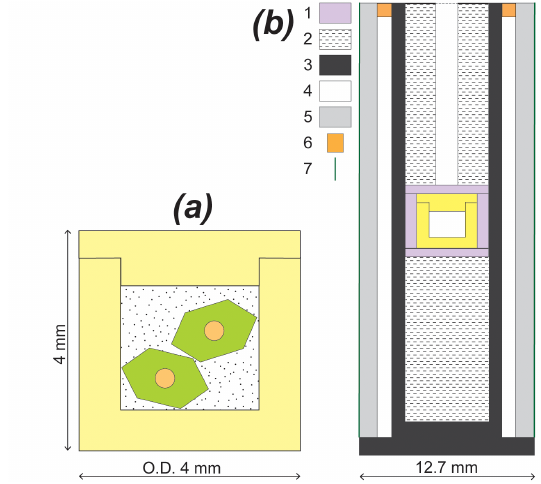
Figure 2. (a) Two olivine phenocrysts are loaded in a thick-walled Au 80 –Pd 20 container along with a mixture of NaCl and powdered olivine. The homogenization experiments are run at P – T conditions above the melting curve of sodium chloride, ensuring hydrostatic conditions inside the container. (b) Sketch of the 1 / 2in.